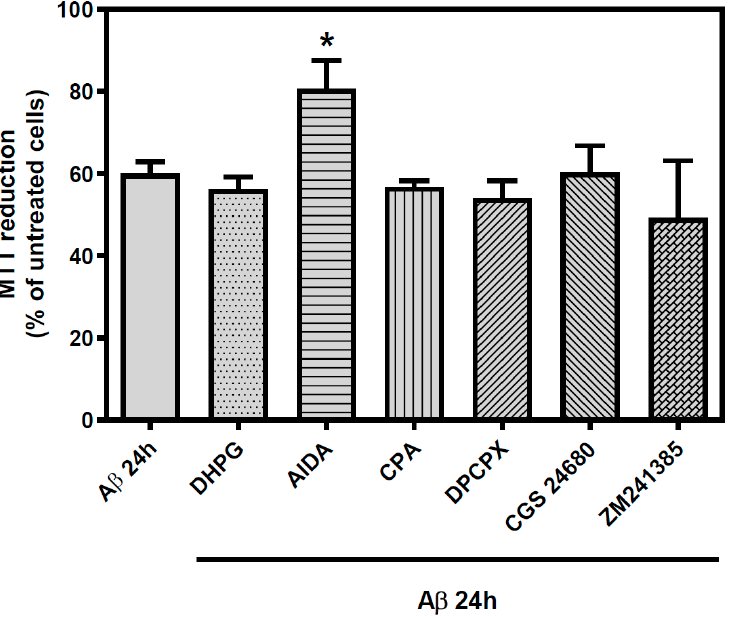
Figure 8. Effect of Group I metabotropic glutamate receptors and adenosine receptors selective ligands on the toxicity exhibited by A β 25-35 exposure. Rat cortical neurons were subjected to selective Group I mGluR and AR ligands prior to 25 µM A β 25-35 for 24 h. DHPG was employed as selective Group I mGluR agonist and AIDA as selective antagonist. CPA was used as selective agonist of A 1 R, DPCPX as A 1 R antagonist, CGS 21680 as A 2A R agonist, and ZM241385 as A 2A antagonist. Each of the ligands were used at 100 µM and added 30 min before A β insult and maintained with amyloid peptide until the beginning of MTT quantification. Mean ± SEM values obtained are represented; each point was measured in triplicate employing, at least, three different cultures. * p < 0.05 significantly different from A β value using one-way ANOVA and Bonferroni’s post-hoc